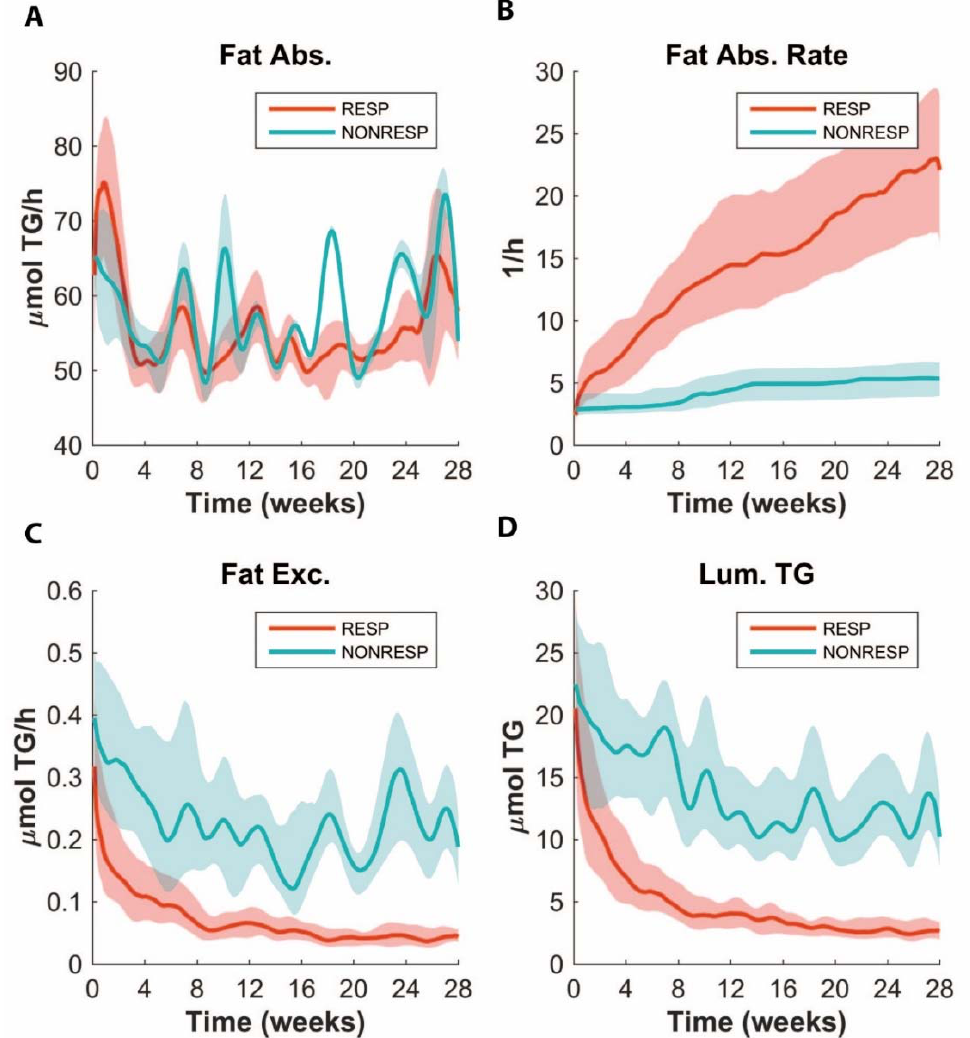
Figure 5. Predictions for fat absorption (Fat Abs.) ( A ), fat absorption rate (Fat Abs. Rate) ( B ), fecal fat excretion (Fat Exc.) ( C ) and intestinal lumen fat content (Lum. TG) ( D ) in responders (RESP) and non-responders (NONRESP), respectively. The bold line represents the median values, whereas the area around the line denotes 30% of solutions around the median. Note how the fat absorption rate is predicted to be slower, while fat excretion and intestinal fat content are predicted to be increased in